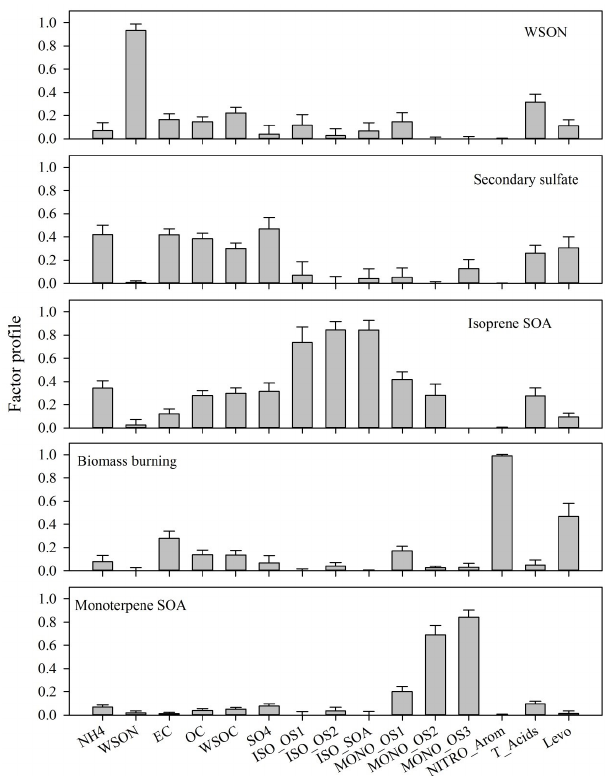
Figure 5. Normalized factor profiles (error bar represents 1 standard